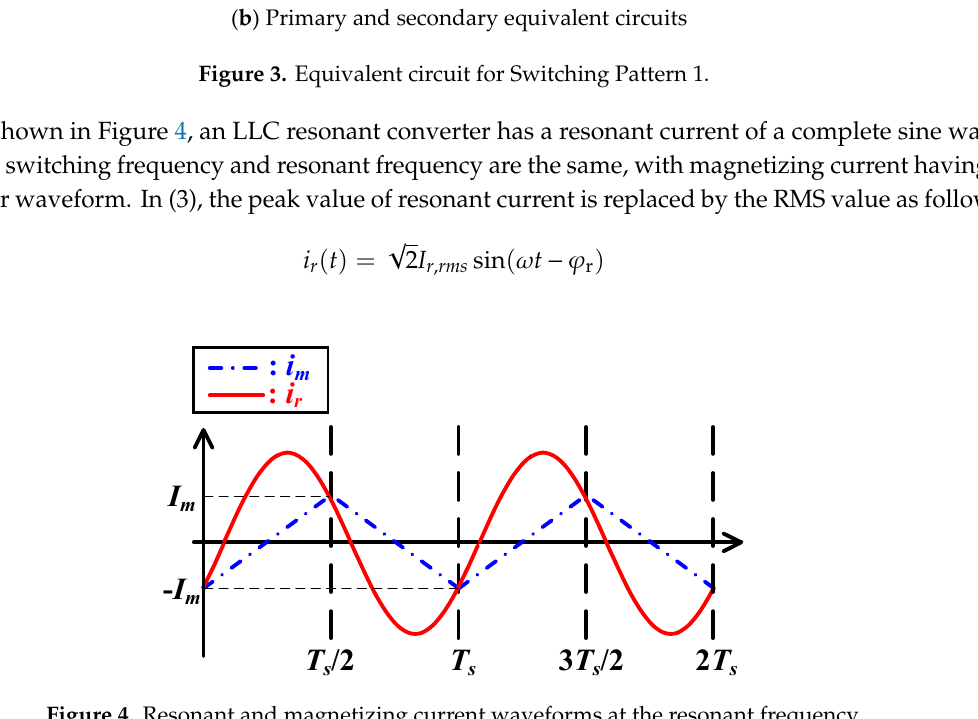
Figure 4. Resonant and magnetizing current waveforms at the resonant frequency.